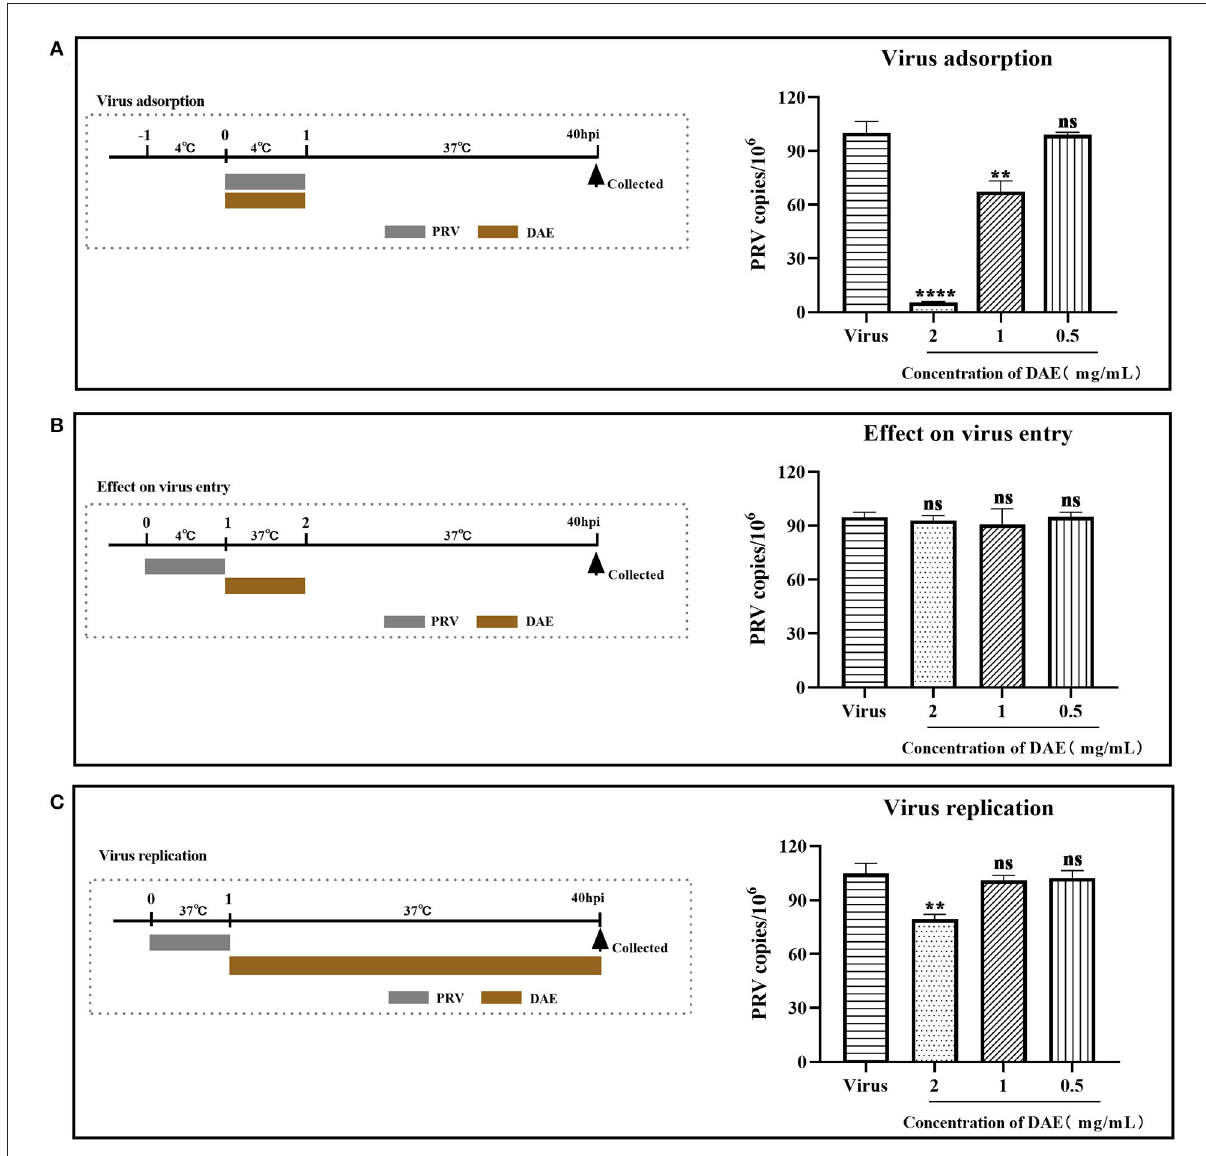
FIGURE3 Influence of different DAE treatment conditions on PRV infection. Upon the addition of DAE under different treatment conditions, after 40h, infected cells were collected, and the virus copy number in the PK15 cells was determined by FQ-PCR. (A) Virus adsorption, (B) effect on